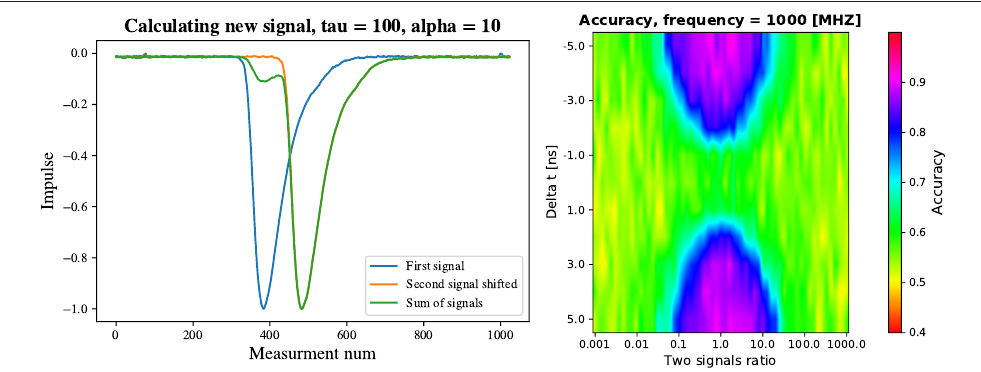
Figure 5. Generated and initial signals (left). The 2-dimensional distribution of arrival time di ff erence and signal ratio of two signals for sampling frequency 1000 MHz (right).